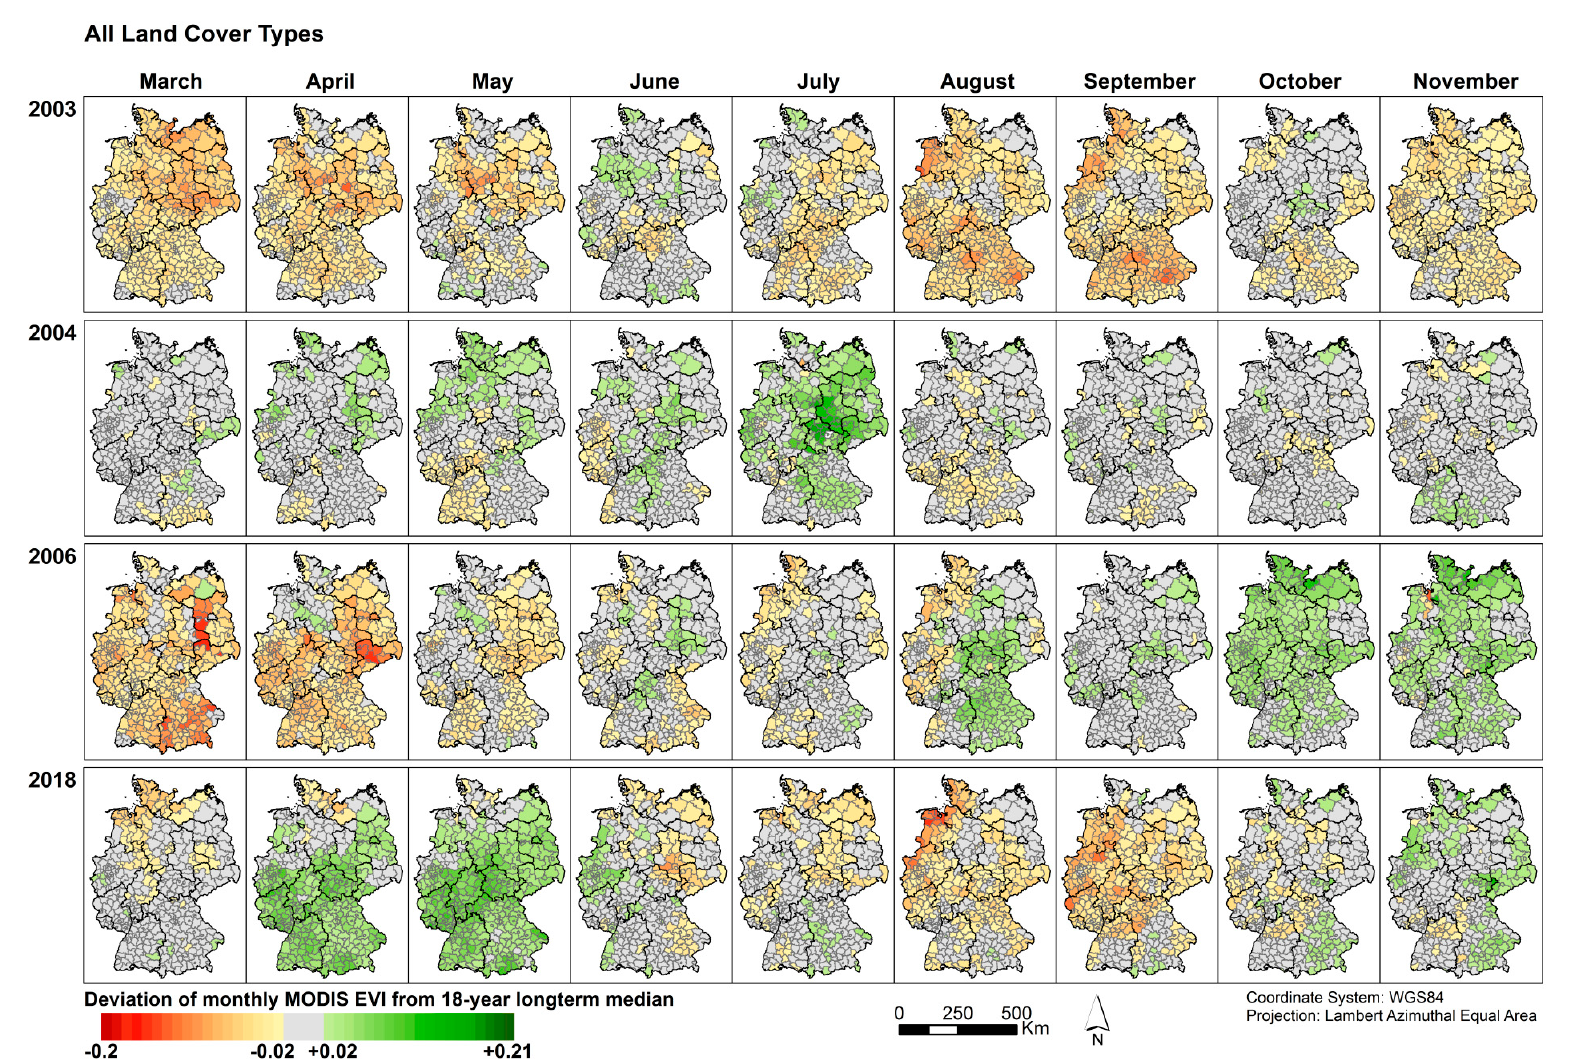
Figure 7. County level monthly EVI anomalies for the vegetation period of four years, including all vegetated land cover types.